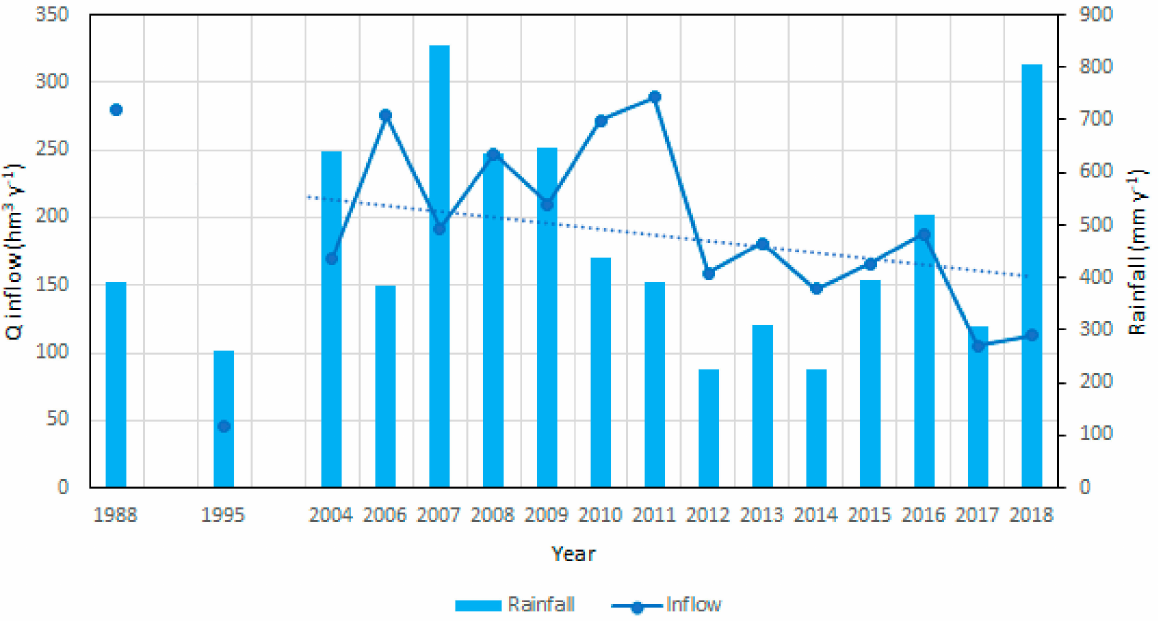
Figure 5. Annual contributions to the Albufera de Valencia showing the trend line and accumulated annual